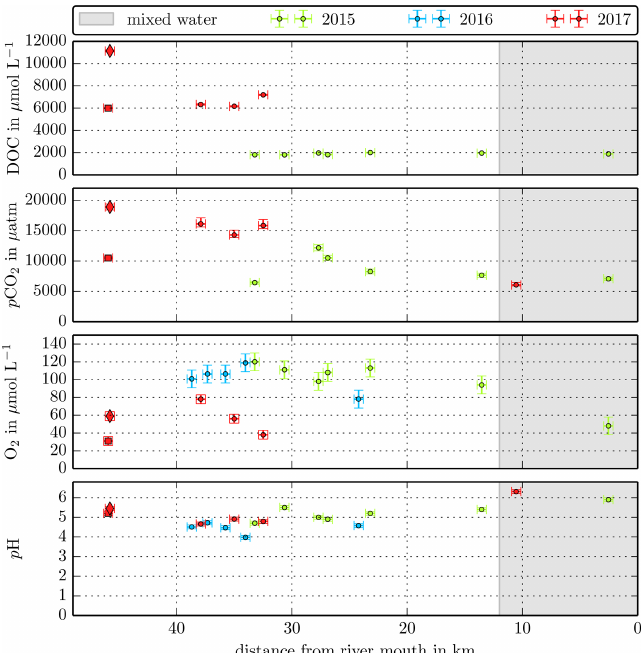
Figure B3. Individual DOC, CO 2 , O 2 , and pH measurements in the Simunjan River versus the distance from the river mouth. Different colours stand for the individual river campaigns, and the grey shaded area indicates regions of S > 1 that were excluded from the data in this